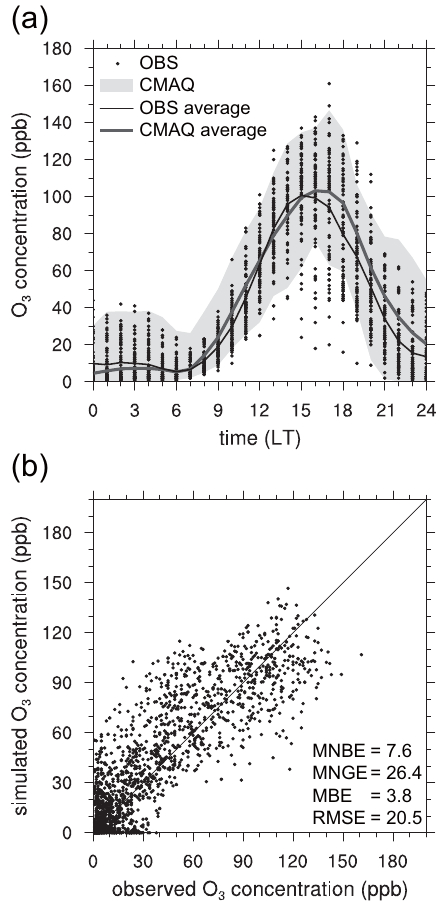
Fig. 2. (a) Diurnal variations of observed and simulated near- surface O 3 concentrations on 24 June 2010. The dots indicate the observed O 3 concentrations at air quality monitoring sites marked in Fig. 1b, and shading indicates the range of simulated O 3 concen- tration at the corresponding locations. The thin and thick lines rep- resent average observed and simulated O 3 concentrations, respec- tively. (b) Scatter diagram of observed O 3 concentrations and sim- ulated ones on 24 June 2010. The MNBE and MNGE refer to the mean normalized bias error and mean normalized gross error, re- spectively, and their units are %. The MBE and RMSE refer to the mean bias error and root-mean-square error, respectively, and their units are